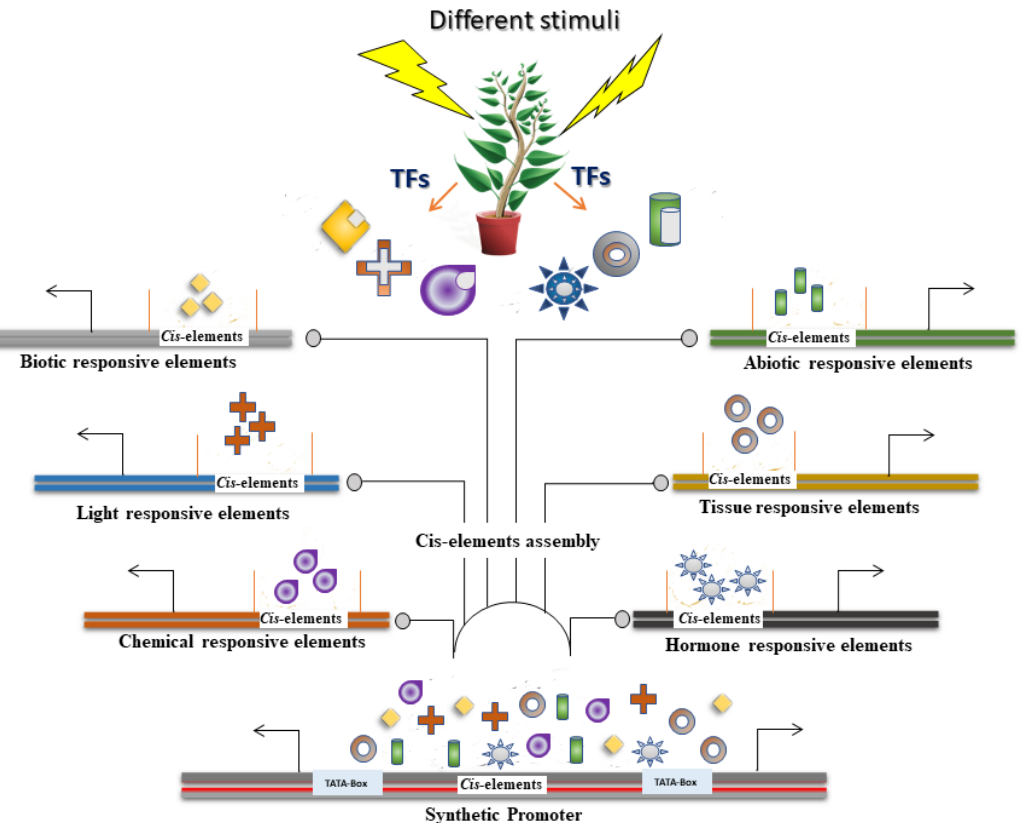
Figure 2. Plant response to different environmental stimuli activates a variety of TFs (shown by different symbols), which binds to specific Cis- elements (shown as respective target symbols) over the targeted promoters. The distribution of Cis- elements greatly differs in different gene promoters and only activates under respective stimuli. The arrangement, distribution, and positioning of Cis- elements from various sources on proximal regions effectively produce synthetic promoters with desirable transcriptional activity in different environmental conditions.